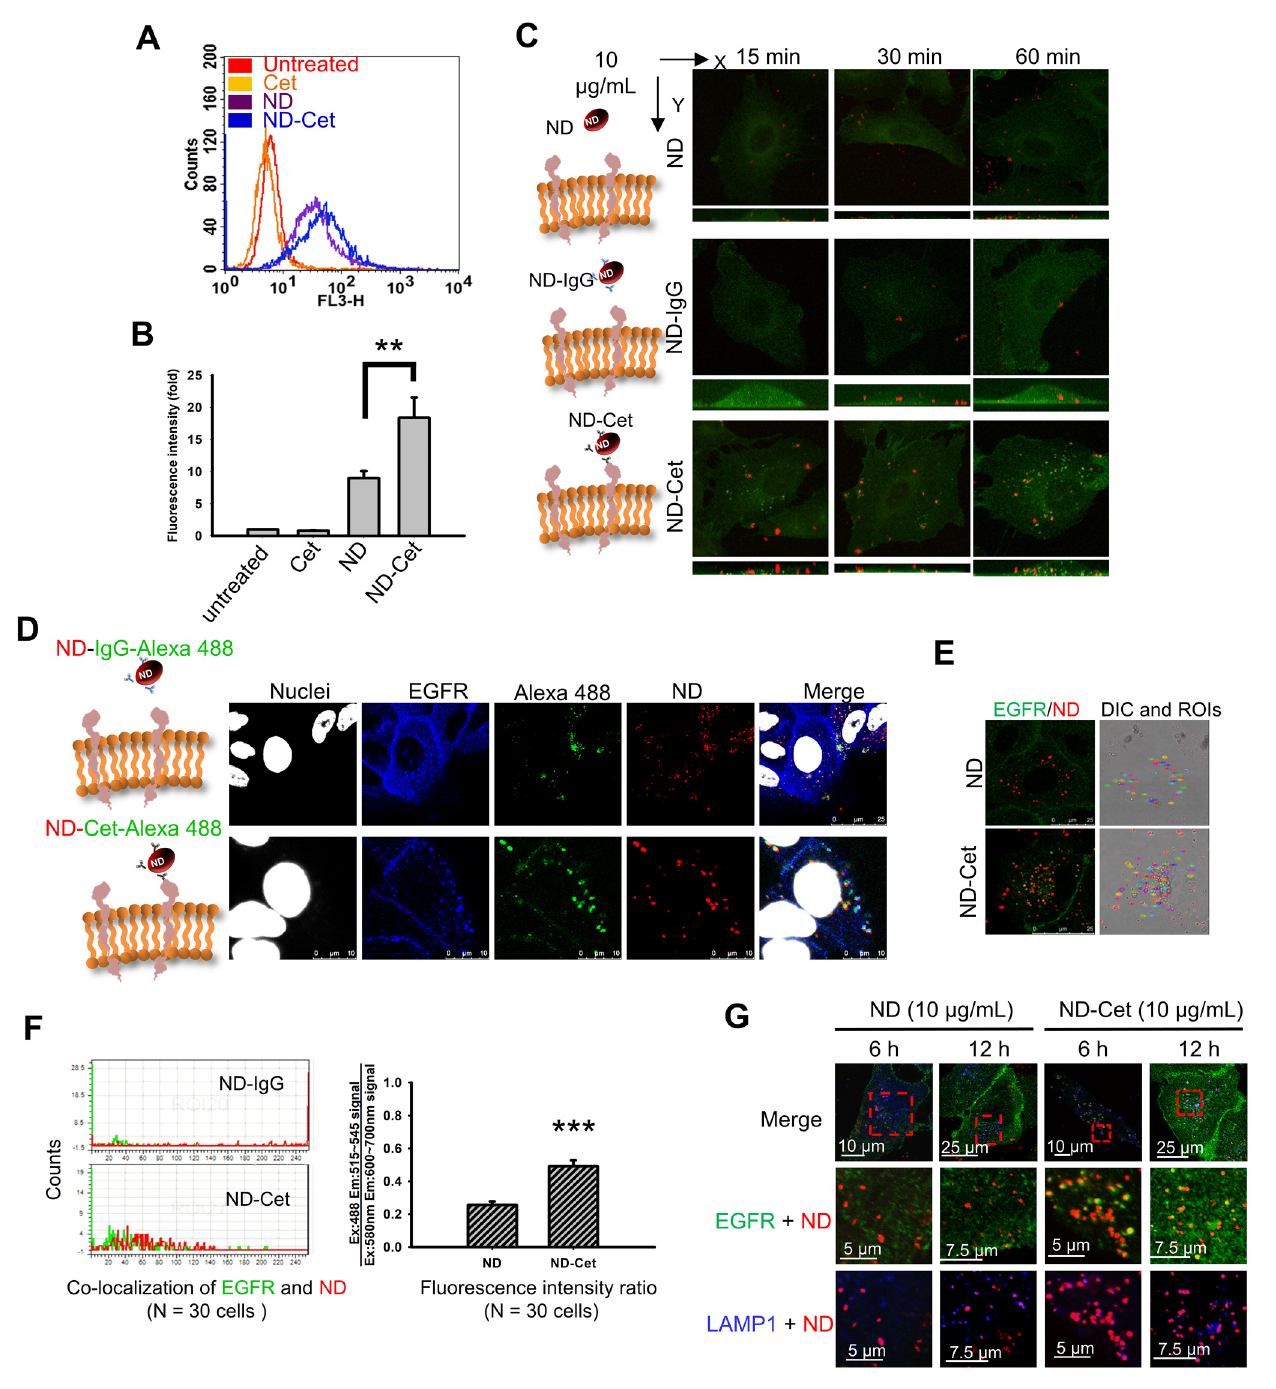
Figure 7. ND-Cet selectively bind EGFR in lung cancer cells. ( A ) Comparison of uptake ability between ND and ND-Cet by flow cytometry. The A549 lung cancer cells were plated at a density of 7 × 10 5 cells per 60 mm petri. Then the cells were treated with or without Cet (12.5 µg/mL), ND (50 µg/mL), and ND-Cet (50 µg/mL) for 24 h. The fluorescence intensity of ND was excited with wavelength 488 nm, and the emission was collected with >650 nm signal range (FL3-H). ( B ) The data of fluorescence intensity was quantified from a minimum of 10,000 cells using CellQuest software. Results were obtained from three separate experiments and the bar represented the mean ± S.E. ** p < 0.01 indicates significant difference between ND treated and ND-Cet-treated cells. ( C ) Detection of ND, ND-IgG, and ND-Cet in short term of time. The cells were treated with 10 µg/mL ND, ND-IgG, and ND-Cet for 15, 30, and 60 min. At the end of treatment, the cells were incubated with rabbit